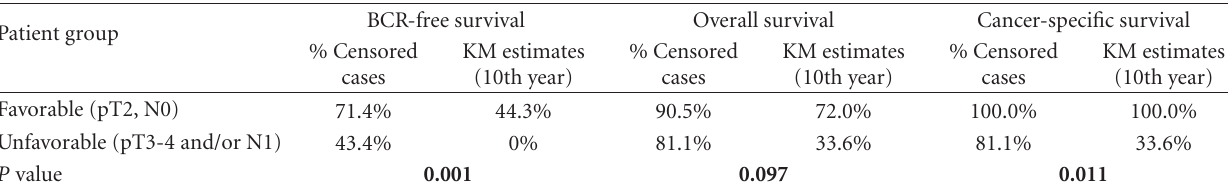
∗ HR: hazard ratio; ∗∗ CI: confidence interval. Table 5: Oncological outcome at the 10th year after surgery in patients with favorable combination of prognostic variables (pT2, N0) versus patients with unfavorable prognostic variables (pT3-4 and/or N1).